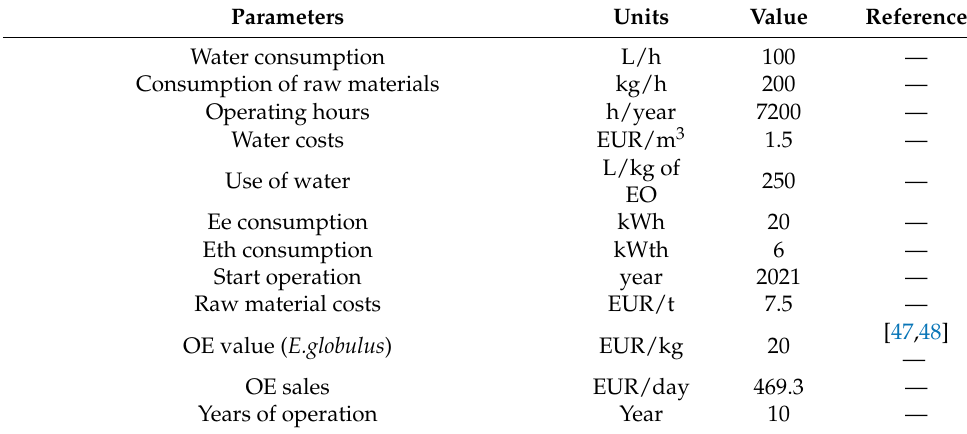
Table 4. Initial assumptions for the essential oil extraction